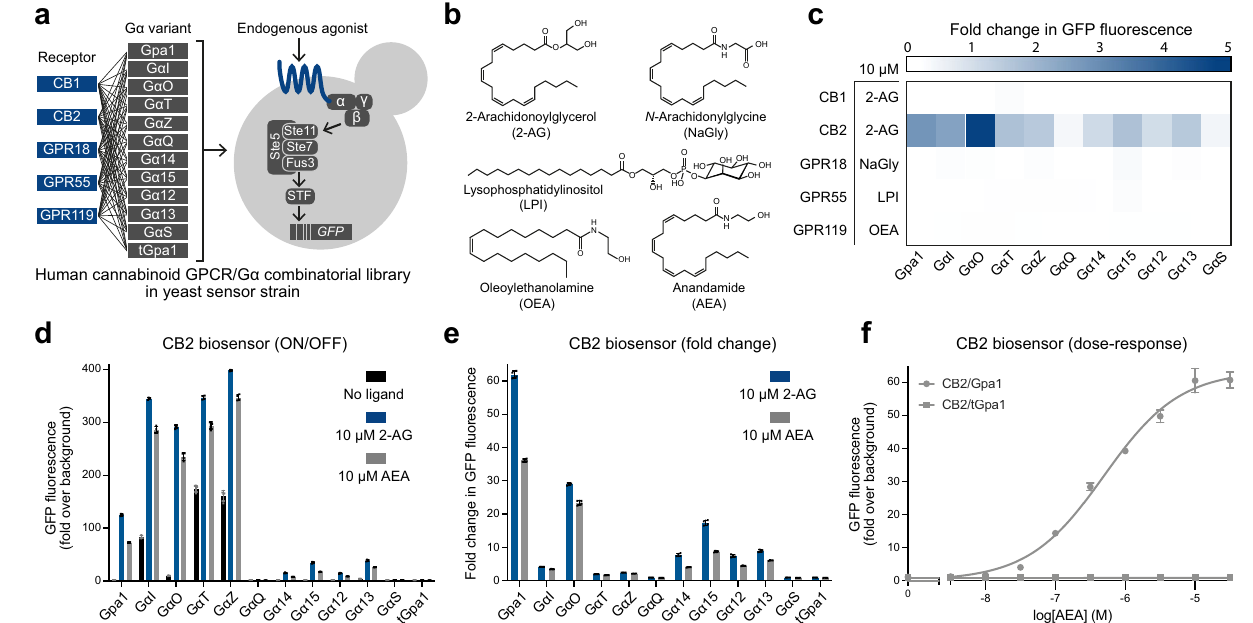
Fig. 1 | Functional coupling of human cannabinoid-responsive G protein- coupled receptors in yeast. a Combinatorial library of fi ve human cannabinoid receptors in combination with 12 G ɑ protein variants introduced into the yeast GPCR chassis strain (yWS677) with a GFP pathway reporter output. b Chemical structure of 2-arachidonoylglycerol (2-AG), N -arachidonylglycine (NaGly), lysopho- sphatidylinositol (LPI), oleoylethanolamine (OEA), and anandamide (AEA). c MaximumfoldchangeinGFPreporteroutputintheGPCR/G ɑ combinatorialstrain library with the addition of 10 µ M of 2-AG (CB1R and CB2R), NaGly (GPR18), LPI (GPR55), and OEA (GPR119). Experimental measurements are GFP levels per cell